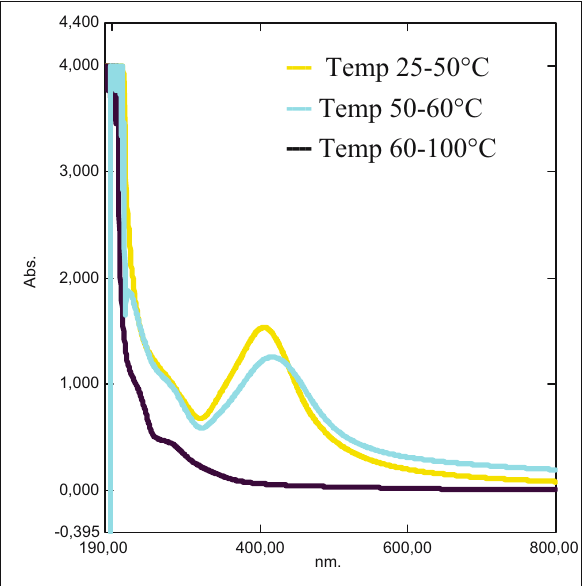
Figure 3: Evaluation of various bioinspired silver nanoparticles spectra prepared by utilizing 1 mL pure plant extract solution with di ff erent ratios of silver salt ( 0.1 mM ) solution.